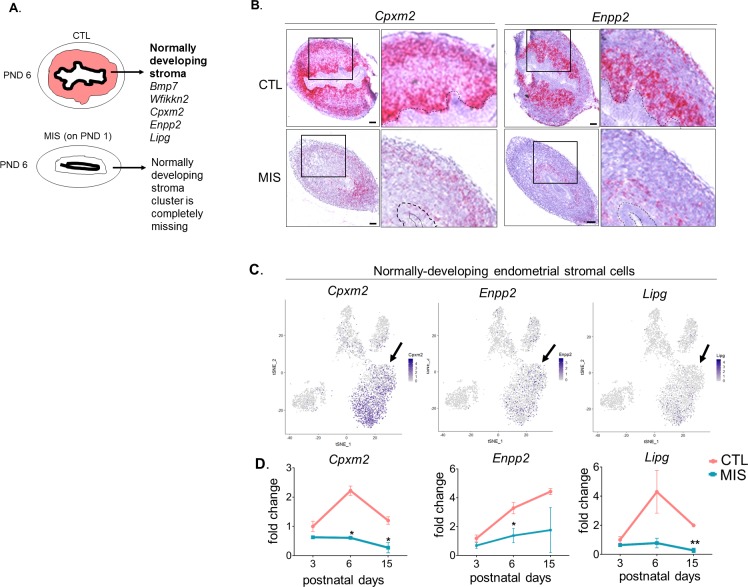
Endometrial stromal layers fail to form when the putative progenitor cells are inhibited by MIS.Rat or mouse pups were injected with empty AAV9 vector control (CTL) or with AAV9-MIS (MIS) on PND 1 and analyzed at different time points (A–D). (A) Representative schema of the CTL and MIS-treated uteri at PND6. Note the absence of the endometrial stroma (orange) in the MIS-treated uteri. (B) Control and MIS-treated mice uteri probed by RNAish using specific endometrial stromal cluster markers at PND 6 (Cpxm2, Enpp2). Scale bars = 50 µm. (C) Expression pattern of Cpxm2, Enpp2, and Lipg (markers of endometrial stroma) in the uterine t-SNE plots (FeaturePlot). (D) QPCR analysis of Cpxm2, Enpp2 and Lipg in CTL and MIS-treated rat uteri at different developmental time points (PND3, 6, 15). (n > 2 for all time points, unpaired Student’s t test, mean ± SEM, *(p<0.05), **(p<0.01)) (Figure 3—source data 3). Note the endometrial stromal markers are significantly down-regulated in the MIS-treated uteri.